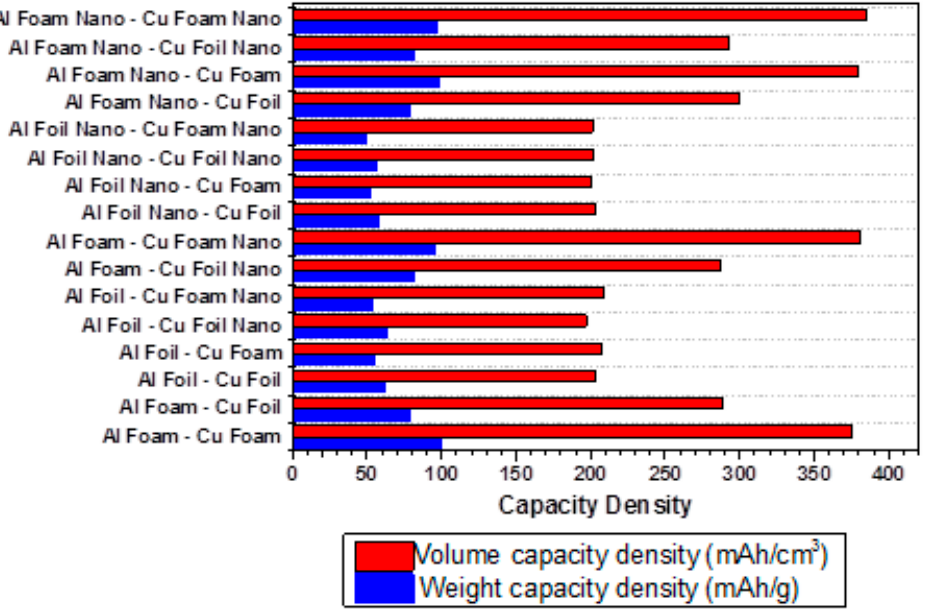
Figure 4. Volume capacity comparison of lithium ion batteries with various metal current collectors.